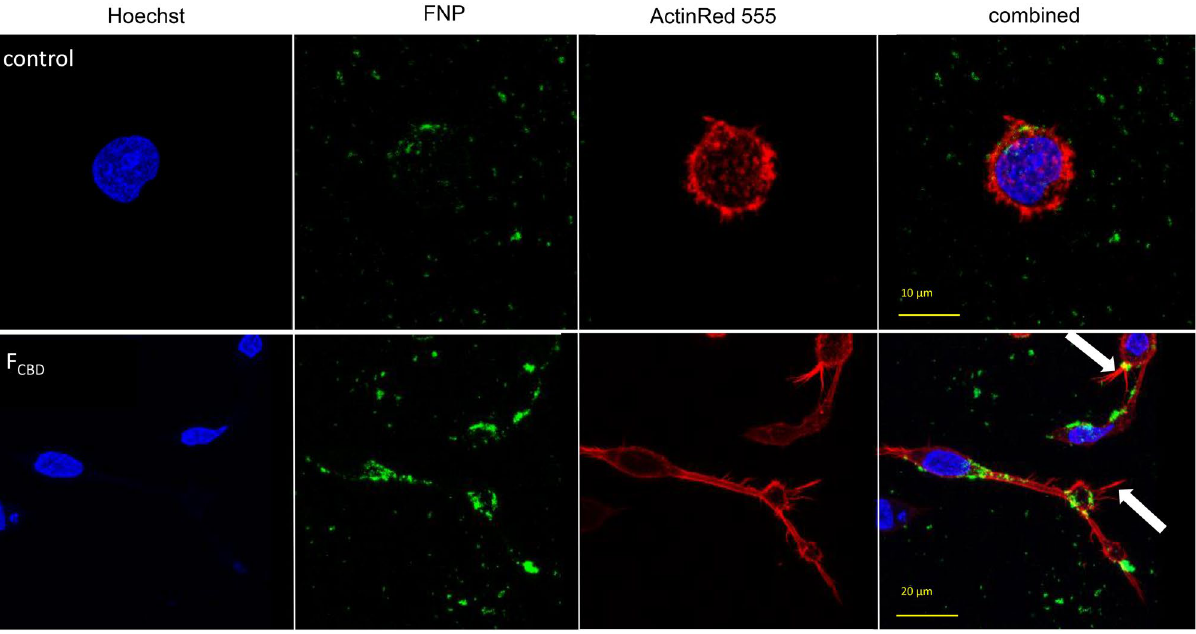
CBD (7 µg/mL). Control (0.7% v/v methanol) treatment served as the solvent (vehicle) control. Cell were stained for F-actin (EasyProbes™ ActinRed 555 Stain, red stain), and nuclei (Hoechst, blue stain); n = 5, in each biological replicate multiple cells were examined (see Table 2). Membrane filopodia-like structures are marked with white arrows. FNP, fluorescent-labeled silica 50–100 nm